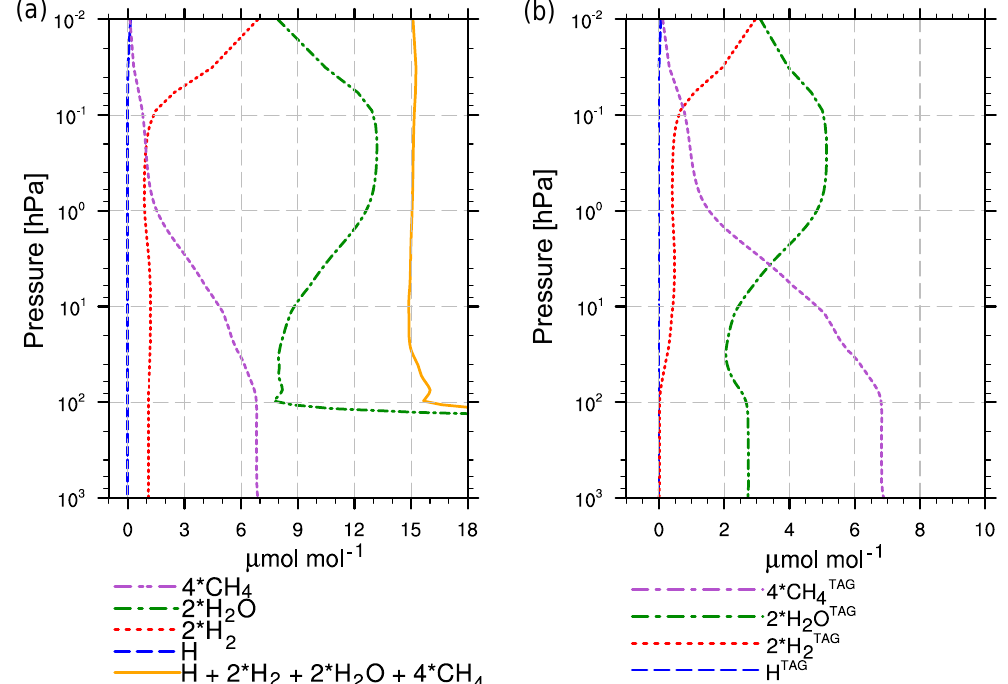
Figure 12. Annual zonal average of general H (a) and tagged H (b) content by species (in µmolmol − 1 ) over the tropics (23 ◦ S–23 ◦